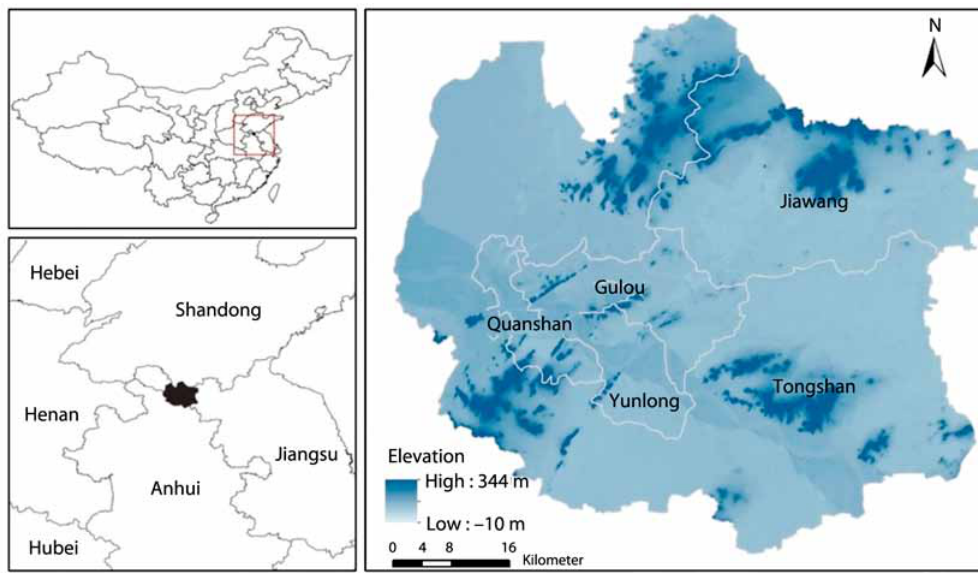
Fig. 1. Location of study area (Xuzhou) and its